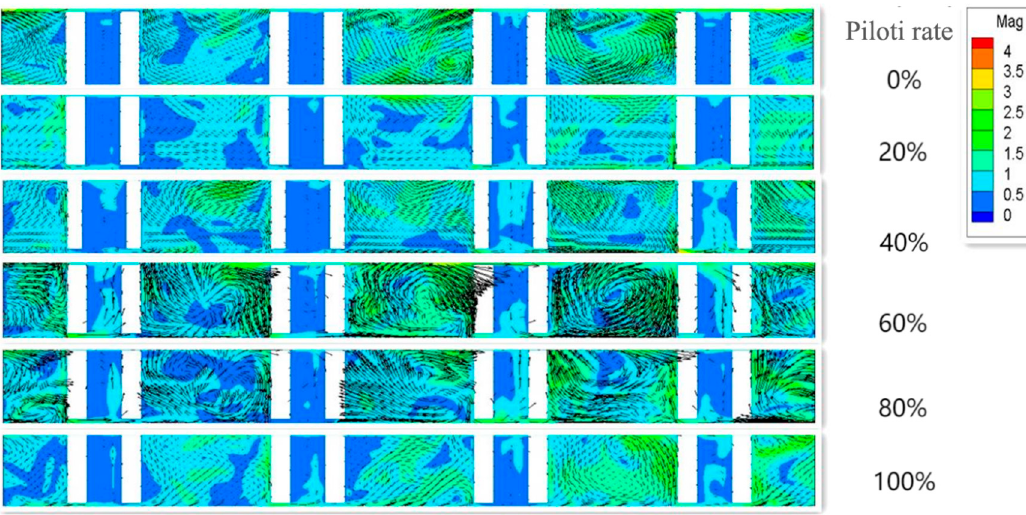
Figure 19. Vector diagram of the target area of Section 1 (Enclosed model).